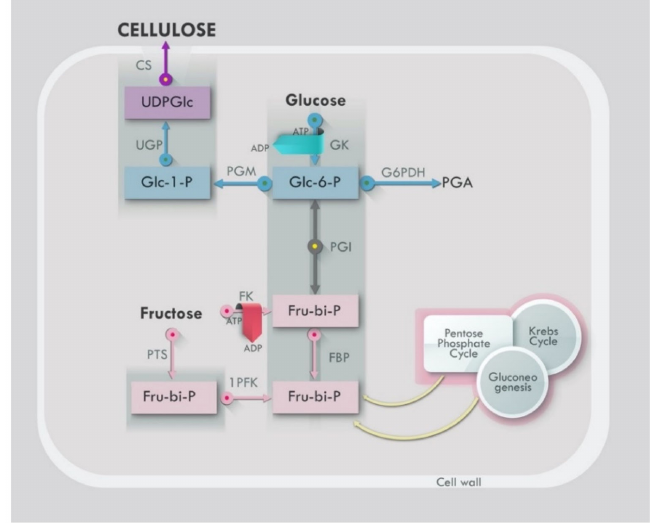
Figure 5. General biosynthesis path of bacterial